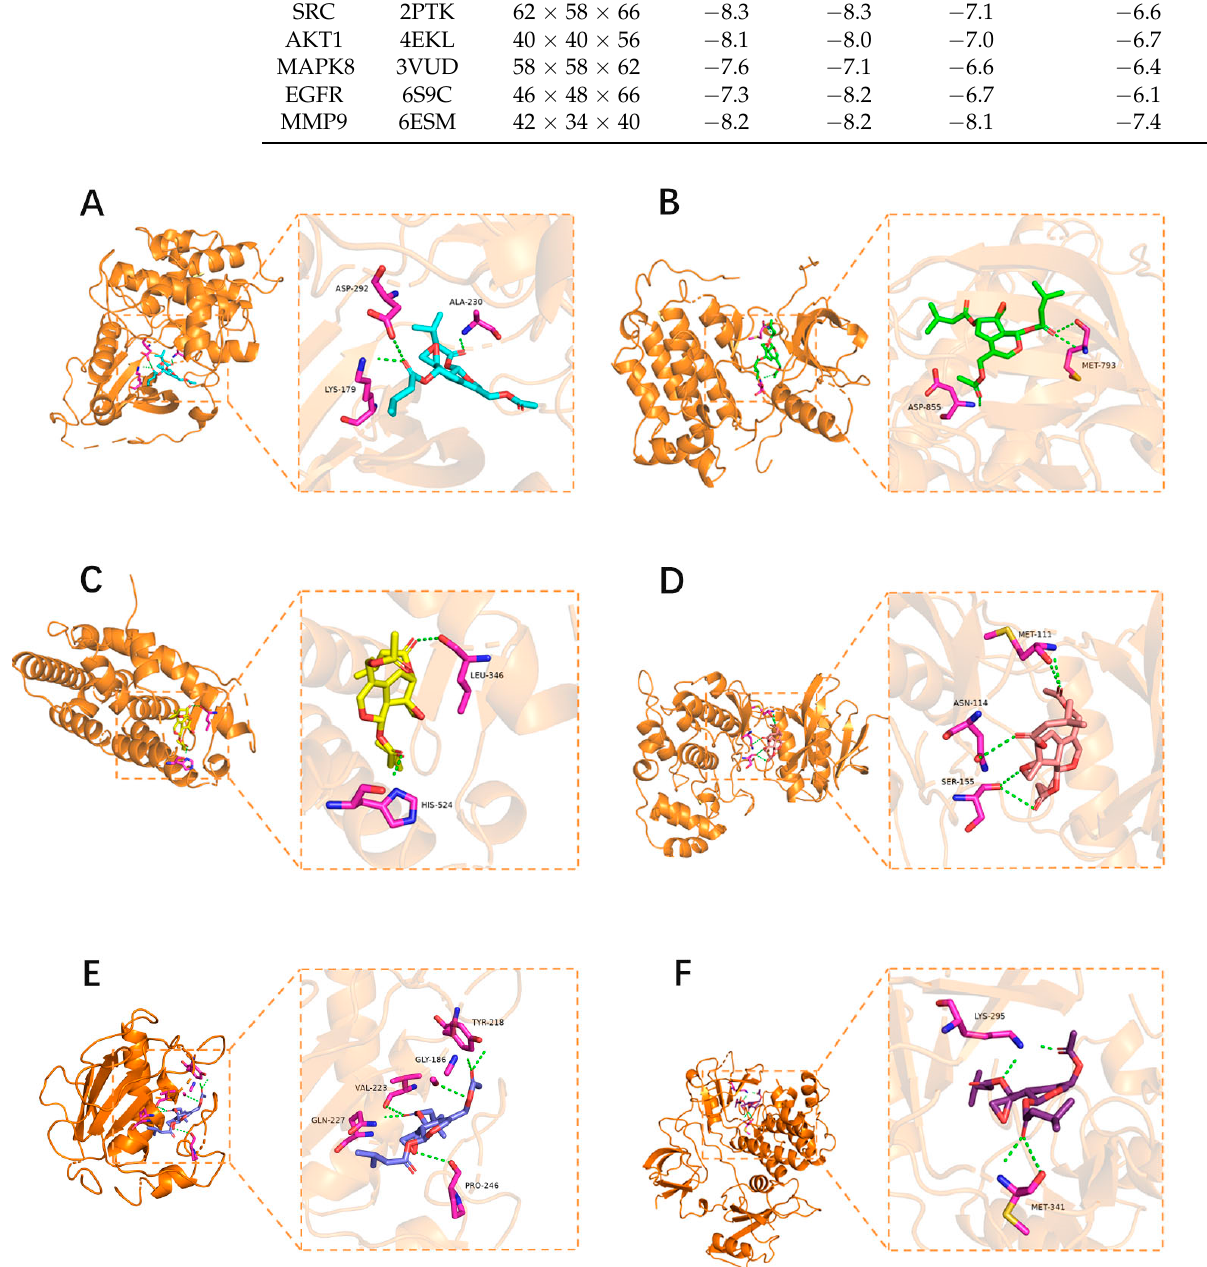
Figure 5. Molecular docking analysis of valtrate and 6 core target proteins. ( A ) AKT1, ( B ) EGFR, ( C ) ESR1, ( D ) MAPK8, ( E ) MMP9, and ( F ) SRC.